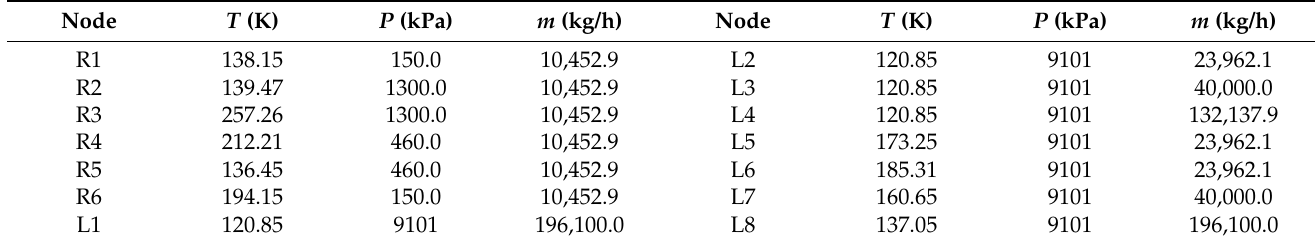
Table 5. Simulation results of LNG and working fluid in System